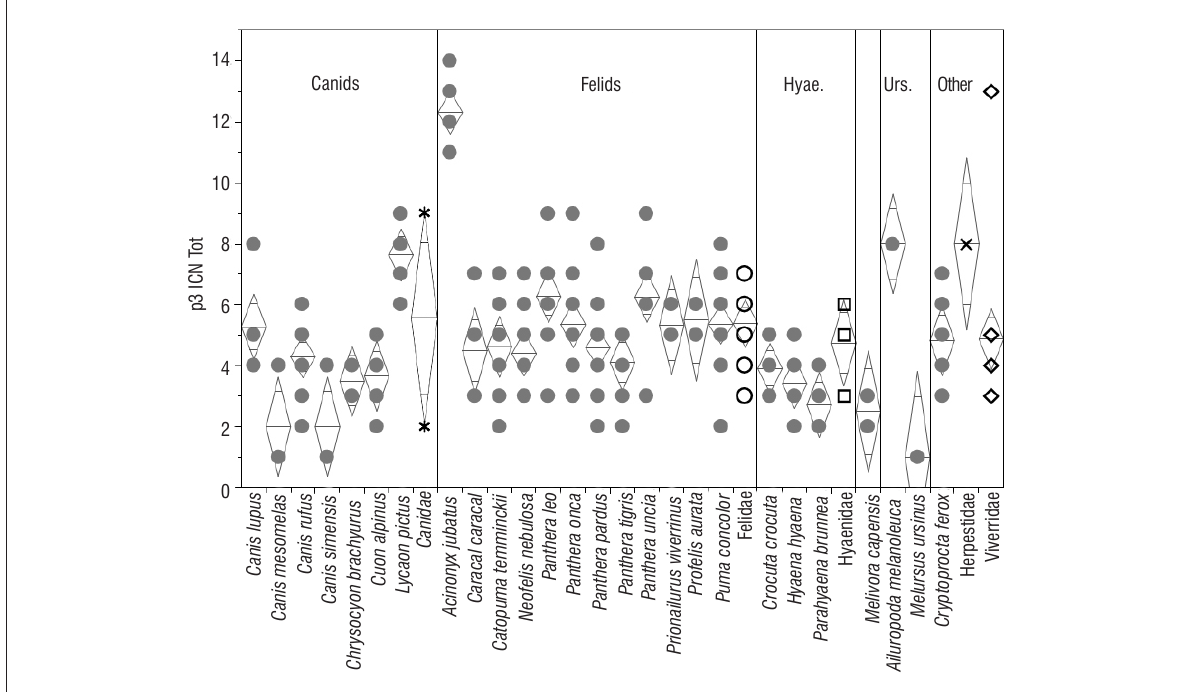
Extant taxa are represented by solid grey circles, Langebaanweg (LBW) canids are represented by asterisks, LBW felids by open circles, LBW hyaenids by open squares, LBW mustelids by open triangles, LBW ursids ( Agriotherium ) by ‘+’ signs, the single analysed LBW herpestid by an ‘x’ sign, and LBW viverrids by open diamonds. Each dotted diamond represents the mean and 95% confidence interval vertical span; the horizontal lines are the mean and ‘overlap marks’ that indicate statistical separation. Figure 9: Intercuspid notch (ICN) scores of the third (p3) lower premolar by